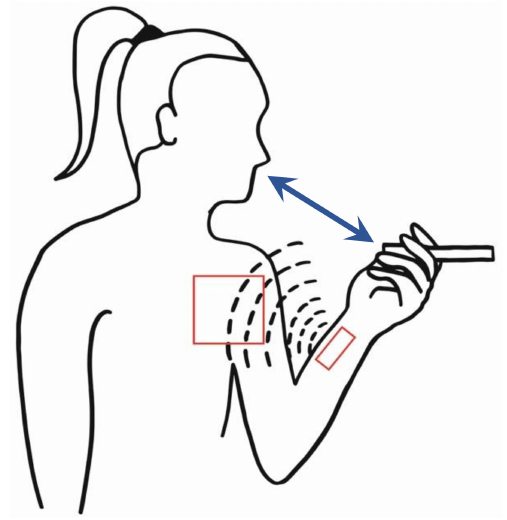
Figure 2. Schematic representation of the system showing the radio frequency (RF) transmitter and the receiver, as implemented in Reference